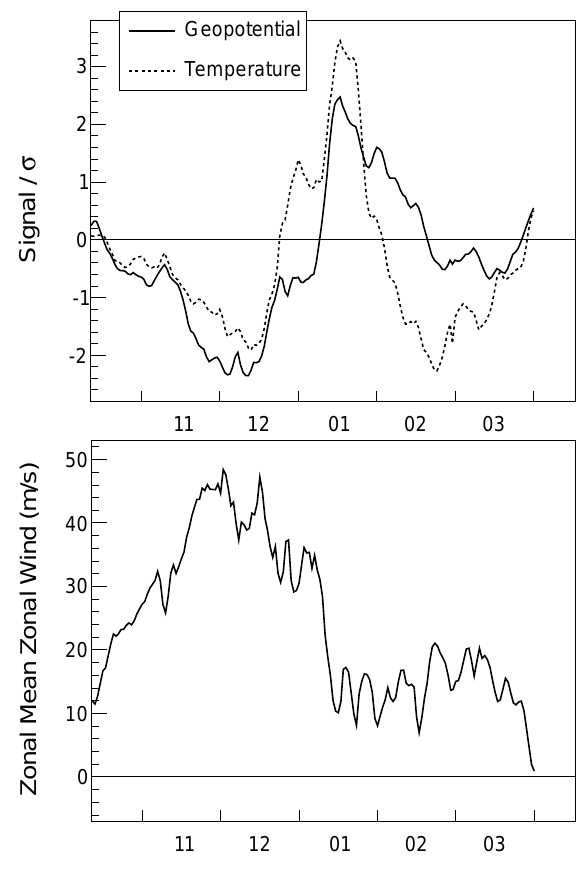
Fig. 5. Observed polar stratospheric variability of the winter 2011/12 until March 31st for geopotential and temperature (top) and the zonal mean zonal wind at 60 ◦ N and 10hPa